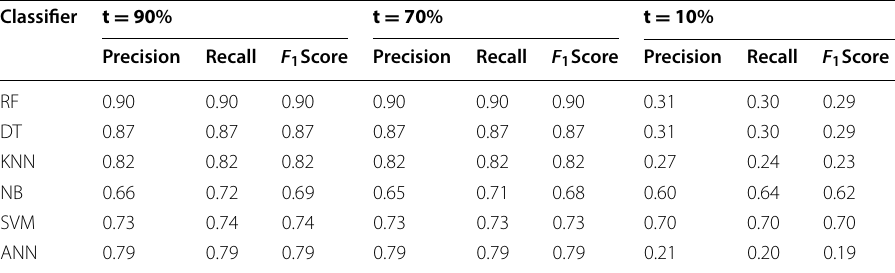
Table 7 Prediction results considering different correlation utilizing the dataset of user U1 Classifier t 90 % t =